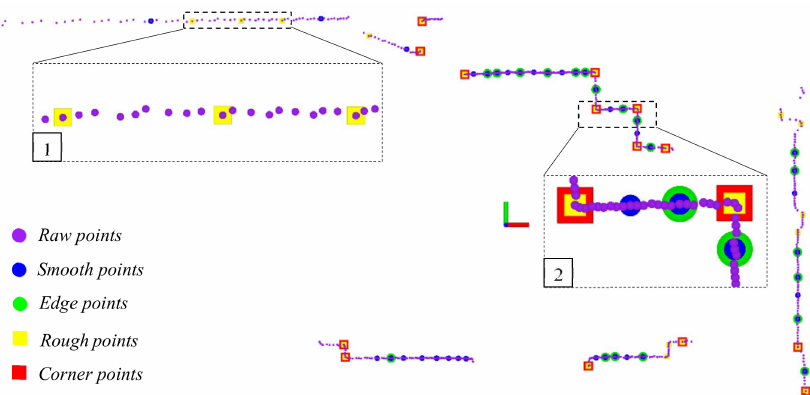
Figure 4. The result of the multi-scale metric procedure. In dotted box 1, the raw points are not strictly distributed in a straight line due to the influence of noise, and we find large-scale metric results in misclassified points. The yellow rectangle should not belong to rough points. In dotted box 2, the red corner points and green edge points are in the correct